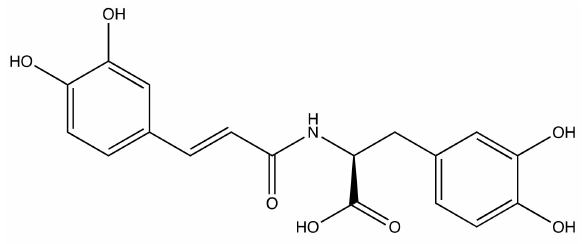
Figure 1. Structure of trans